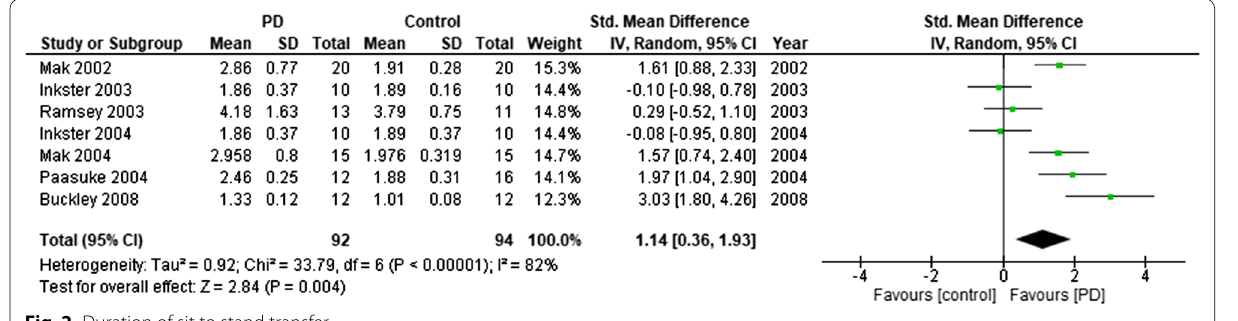
Fig. 2 Duration of sit to stand